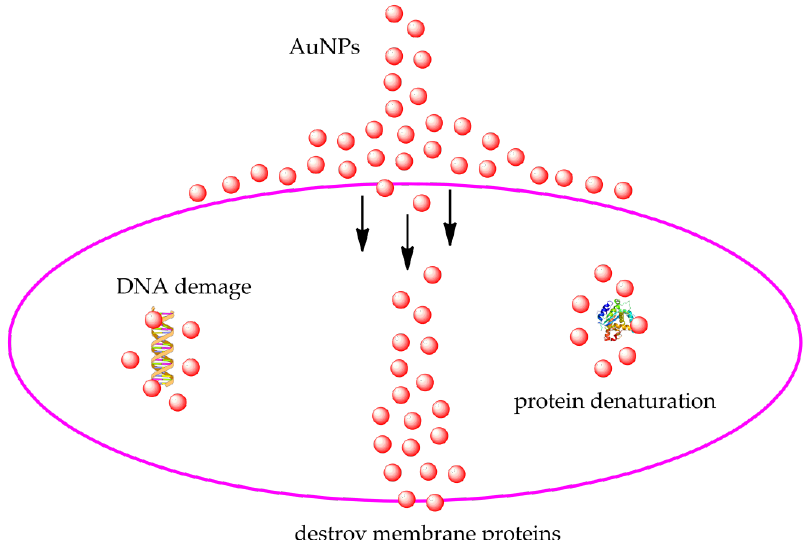
Figure 6. Various mechanism of antimicrobial activity of AuNP@antibiotics/antibacterial coatings.